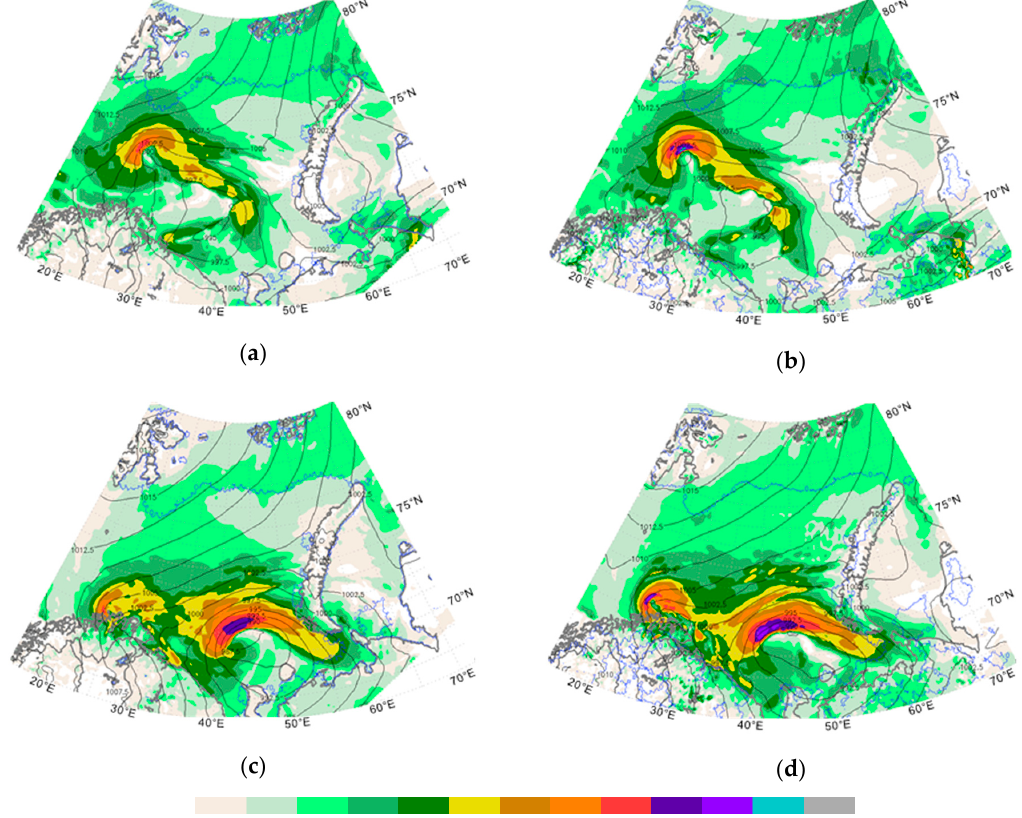
Figure 4. COSMO-CLM-A6.6 (left) and ICON-A6.5 (right) comparison: sea-level pressure and wind gusts from base time 00:00 UTC 26 November 2019; ( a , b ) valid time 18:00 UTC 26 November 2019; ( c , d ) valid time 06:00 UTC 27 November 2019.